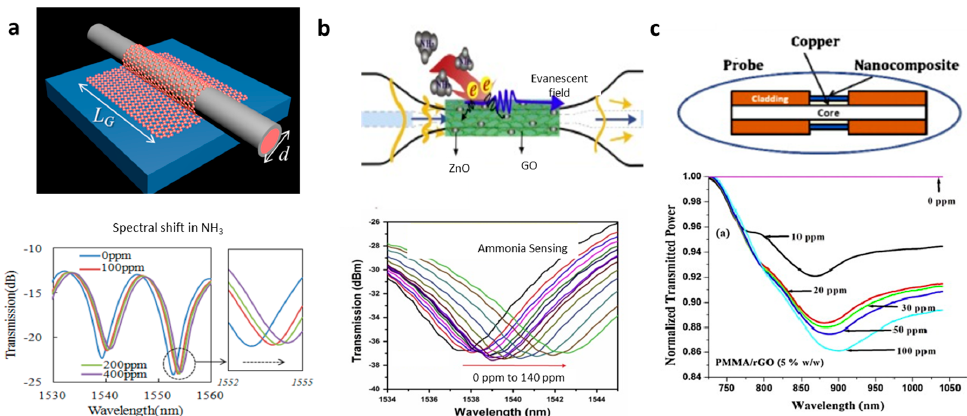
Figure 10. Optical gas sensors based on graphene-wrapped microfiber structures. ( a ) NH 3 /H 2 O sensor based on CVD graphene-microfiber multimode interferometer, ( b ) NH 3 gas sensor based on ZnO-GO-covered graphene-microfiber multimode interferometer, ( c ) NH 3 gas sensor based on SPR on a PMMA/graphene/Cu-covered microfiber. Here the figures are reproduced from Refs. [46,91,92].